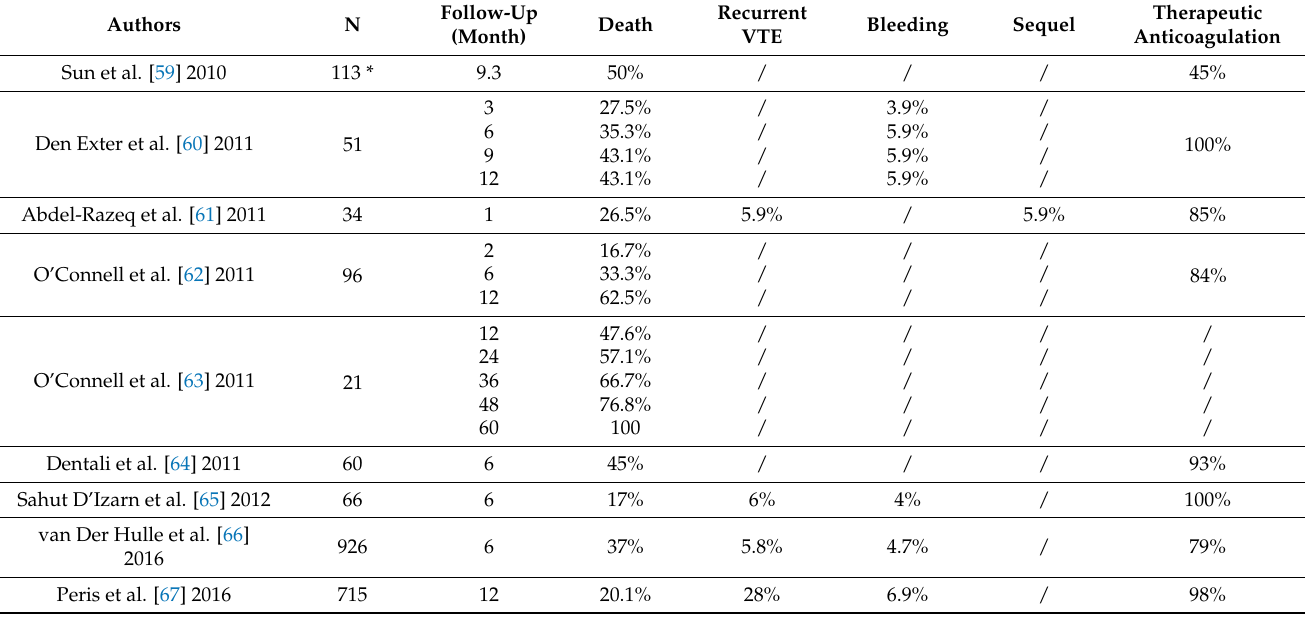
Table 2. Incidence of death rate, recurrent VTE, bleeding, and sequel in unsuspected